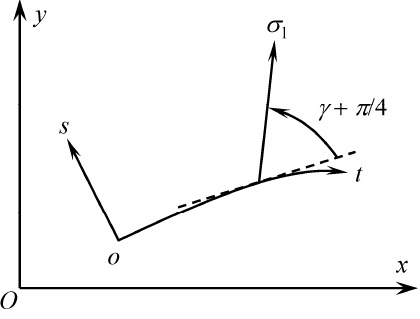
Figure 1. Cartesian and ( t, s ) – coordinate systems.